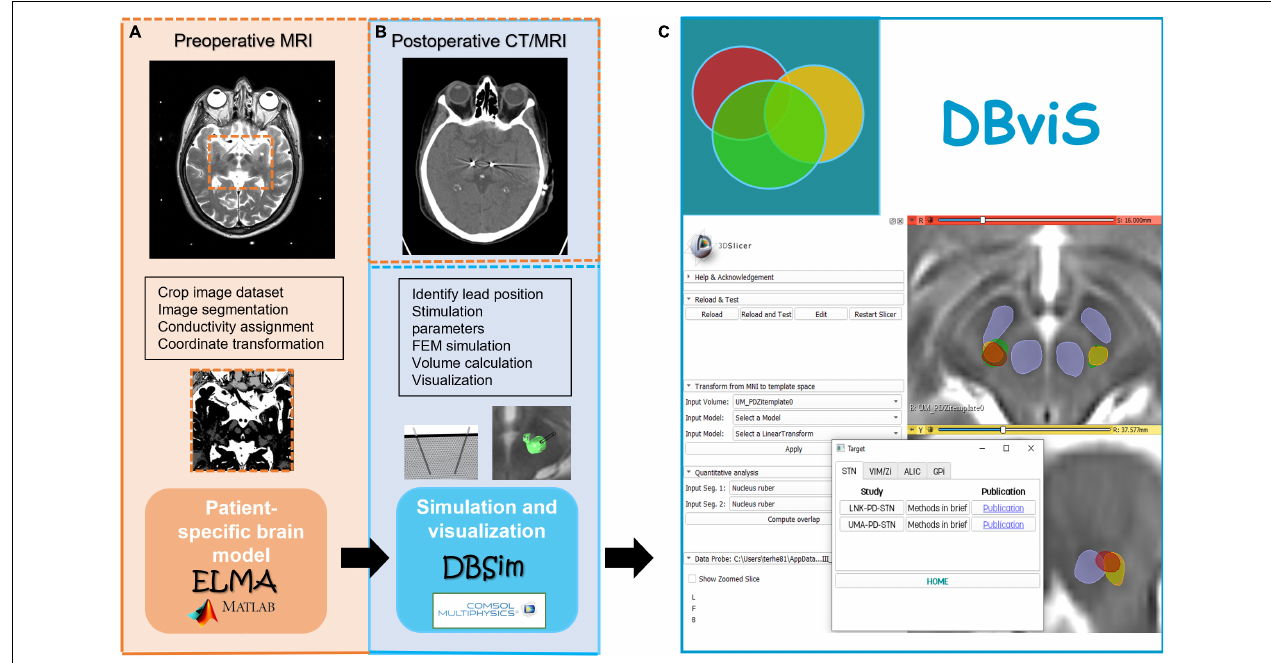
FIGURE 7 | (A) Brain model creation and (B) patient-specific electric field simulation applications (APPs), and their link to the modeling and simulation software. The concept in collecting, presenting, and comparing DBS simulation studies using the DBviS APP is shown in (C)